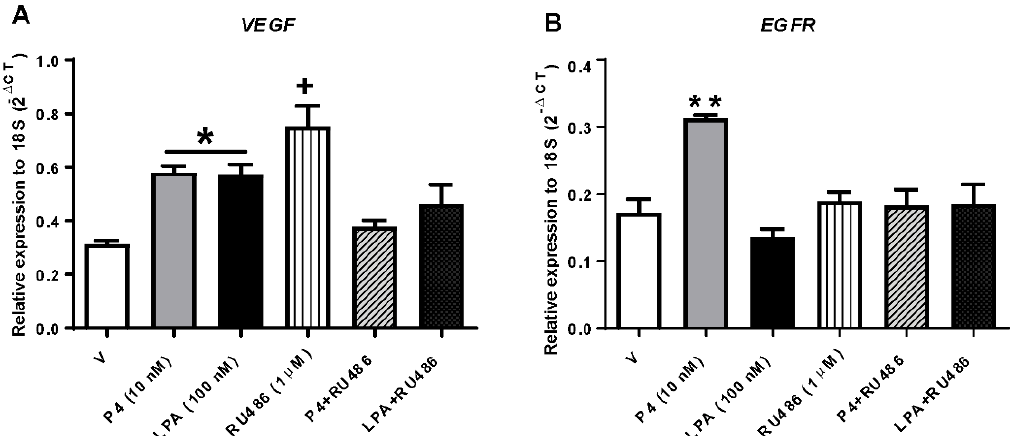
Figure 3. LPA modulates VEGF but not EGFR mRNA expression levels in GBM cells. U251 cells were treated with P4, LPA, RU486 and the combination of these treatments: P4 + RU486, LPA + RU486, or V (Vehicle; 0.1% ethanol) for 24 h, subsequently the gene expression of ( A ) VEGF and ( B ) EGFR was determined by RT-qPCR. Each column denotes the mean ± S.E.M. of each treatment, n = 4. The one-way ANOVA statistical test followed by a Tukey post-test determined the statistical difference * p < 0.02 P4 and LPA vs. V; + p < 0.009 vs. V and the combined treatments; ** p < 0.01 P4 vs. all other treatments.